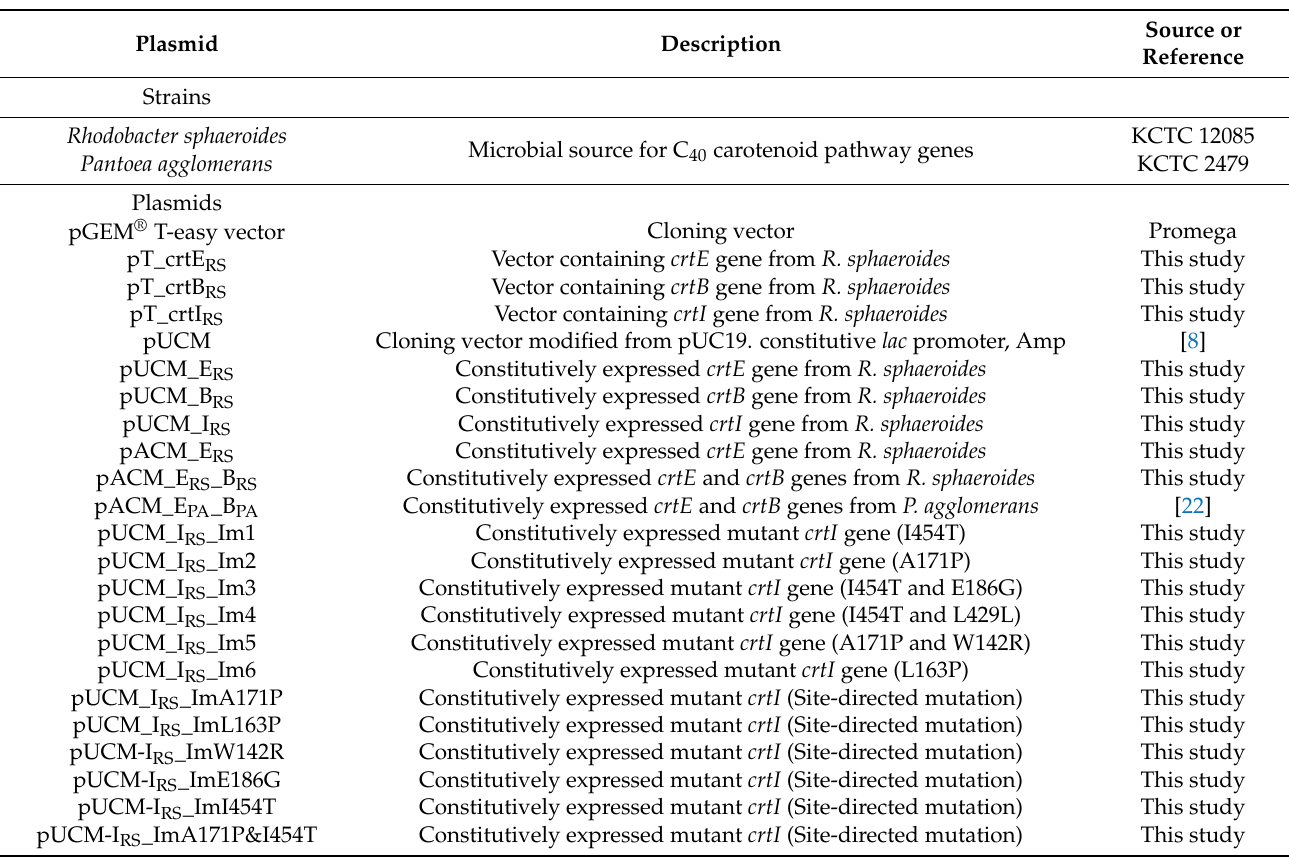
Table 1. Strains and plasmids used in this study.